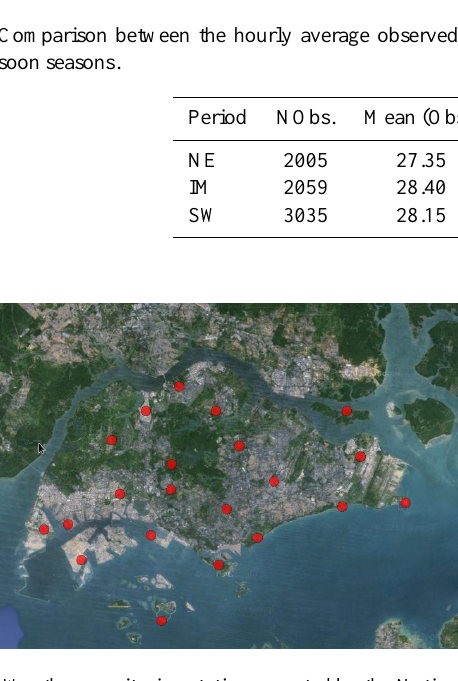
Figure 3. Weather monitoring station operated by the National En- vironment Agency of Singapore.